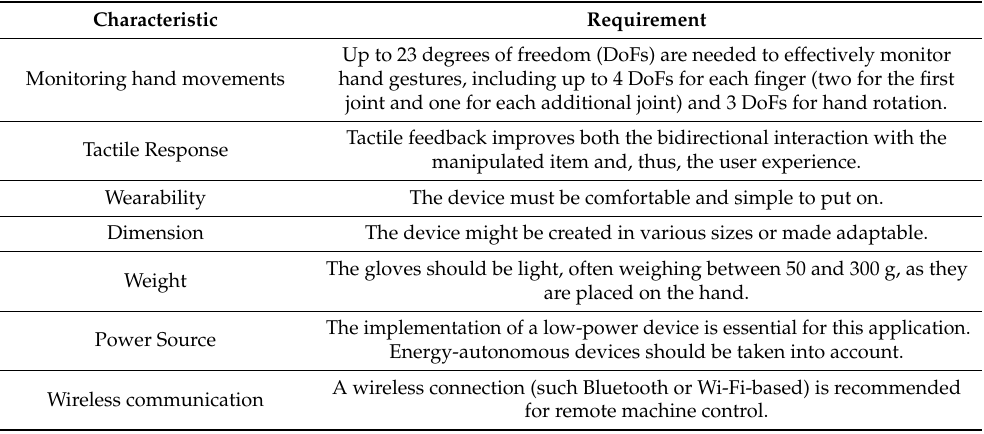
Table 3. Basic characteristics for intelligent gloves